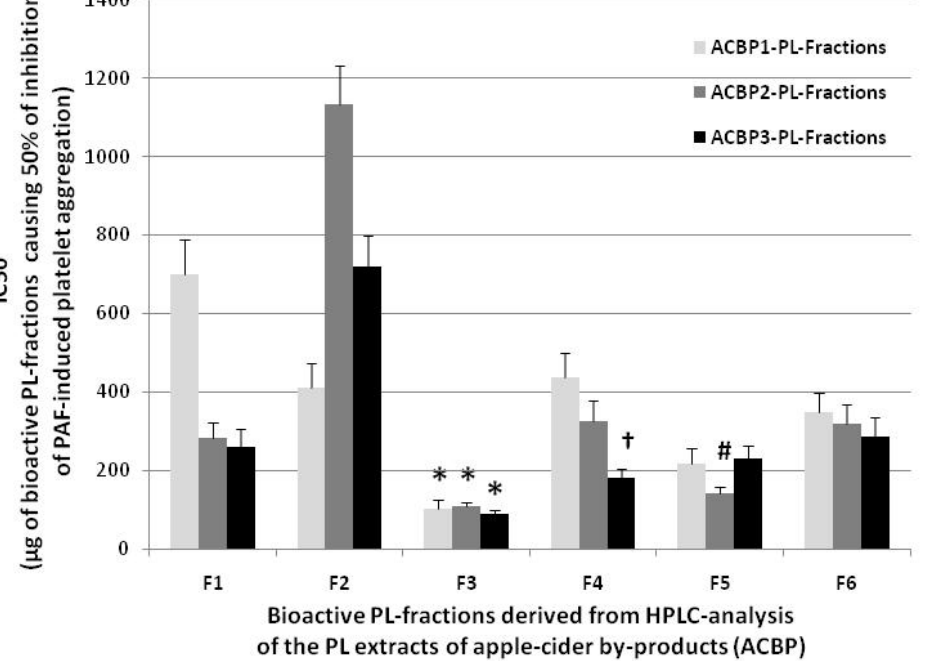
Figure 3. The anti-inflammatory potency of the bioactive HPLC-derived PL-subclasses for each ACBP against human platelet aggregation induced by the inflammatory and thrombotic mediator PAF. Results are expressed as means of the IC 50 (half-maximal inhibitory concentrations) values in µg of the bioactive PL-compounds of each PL-fraction in the aggregometer cuvette that causes 50% inhibition of PAF-induced platelet aggregation (the lower the IC 50 value for a bioactive lipid fraction the higher its inhibitory effect against the PAF-associated inflammatory pathways). *denotes statistically significant difference (p < 0.05) when the anti-PAF potency (IC50 value) of the bioactive PL-fraction 3 (F3) corresponding to the PL-subclass containing bioactive PC molecules were compared with the relative anti-PAF potency of all the other PL-fractions for each ACBP apple pomace. “#” denotes statistically significant difference (p < 0.05) when the anti- PAF potency (IC50 value) of the bioactive PL-fraction 5 (F5) of the ACBP2, corresponding to the PL-subclass containing bioactive PE molecules were compared with the relative anti-PAF potency of the same PL-fraction F5 of the other two ACBP1 and ACBP3 apple pomaces, as well as with all the other PL-fractions for each ACBP (apart from the F4 of ACBP3). “†” denotes statistically significant difference (p < 0.05) when the anti-PAF potency (IC50 value) of the bioactive PL-fraction 4 (F4) of the ACBP3, corresponding to the PL-subclass containing bioactive SM and several glycolipid molecules were compared with the relative anti-PAF potency of the same PL-fraction F4 of the other two ACBP1 and ACBP2 apple pomaces, as well as with all the other PL-fractions for each ACBP (apart from the F4 for all ACBP). (Abbreviations: PL: polar lipids; F: PL-fraction corresponding to specific PL-subclass that were derived by HPLC-analysis of the PL- extracts for each ACBP; ACBP: apple cider by-products (apple pomace); ACBP1: apple cider by-products of low in tannins Jonagold apple variety; ACBP2: apple cider by-products of medium in tannins Dabinett apple variety; ACBP3: apple cider by-products of high in tannins Aston Bitter apple variety; PAF: platelet activating factor.